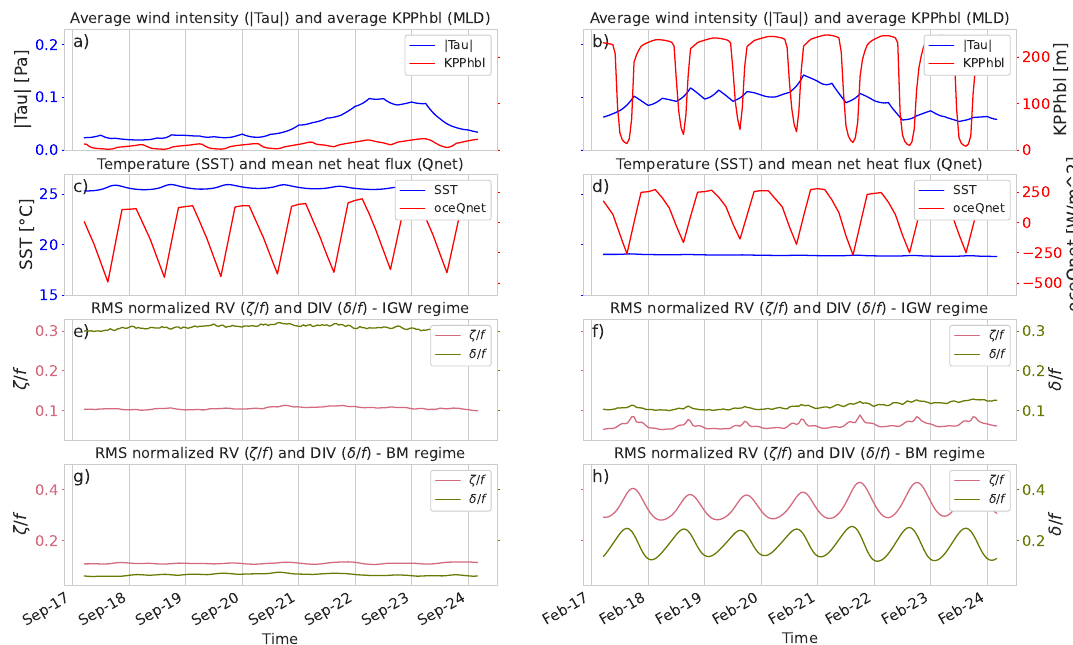
Figure 11. Time series of dynamical variables for the study area centered at 26.6 ◦ N within the Canary current from 17 September to 24 September 2012 ( a , c , e , g ) and from 17 February to 24 February 2012 ( b , d , f , h ). First row ( a , b ): mean values for the wind stress ( | τ | , blue) and the KPP turbulent boundary layer depth ( KPP hbl , red). Second row ( c , d ): mean values for the sea surface temperature (T, blue) and ocean net heat flux (oceQnet, red). Third row ( e , f ): standard deviations of the normalized vorticity ( ζ / f , magenta) and divergence ( δ / f , green) fields in the internal gravity wave (IGW) regime. Fourth row ( g , h ): standard deviation of the normalized vorticity ( ζ / f , magenta) and divergence ( δ / f , green) fields in the balanced motion (BM)